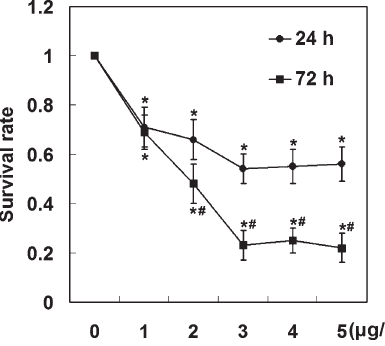
Figure 1. Cell survival following low-dose cisplatin treatment. HepG2 cells were treated with 0-5 m g/mL cisplatin, and cell survival was determined by the MTT assay after 24 or 72 h. Data were calculated from two independent experiments. *P , 0.05 compared with 0 m g/mL cisplatin treatment; # P , 0.05 compared with 24 h ( x 2